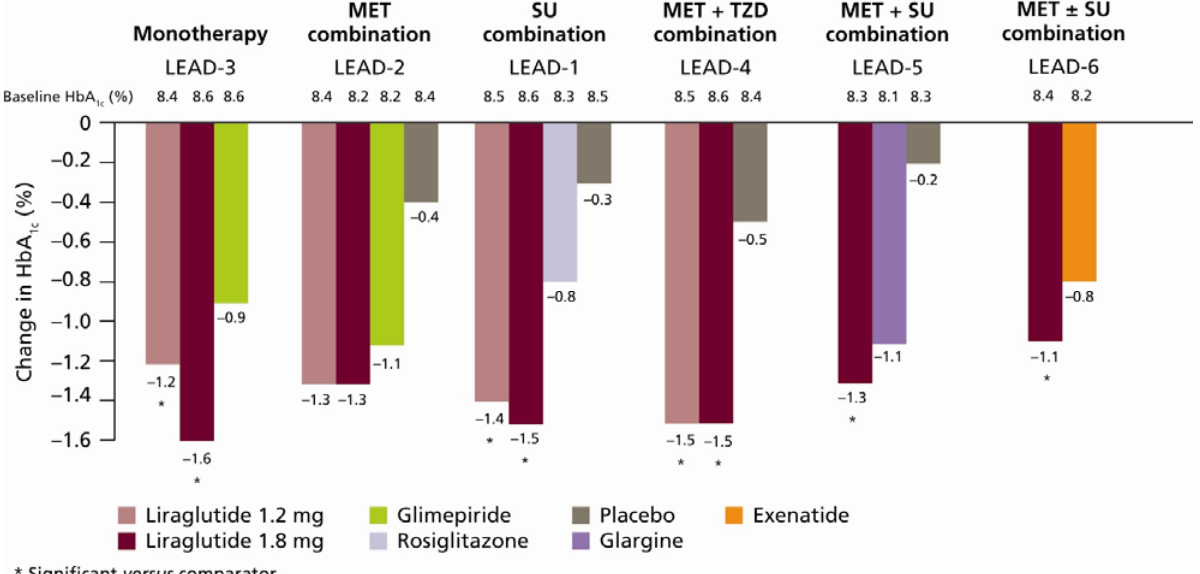
Figure 7. Change in HbA from Baseline (LEAD-1–6) for Overall Population (LEAD-4– 1c 6), Add-on to Diet and Exercise (LEAD-3) and Add-on to Previous OAD Monotherapy (LEAD-1–2) [25–30].